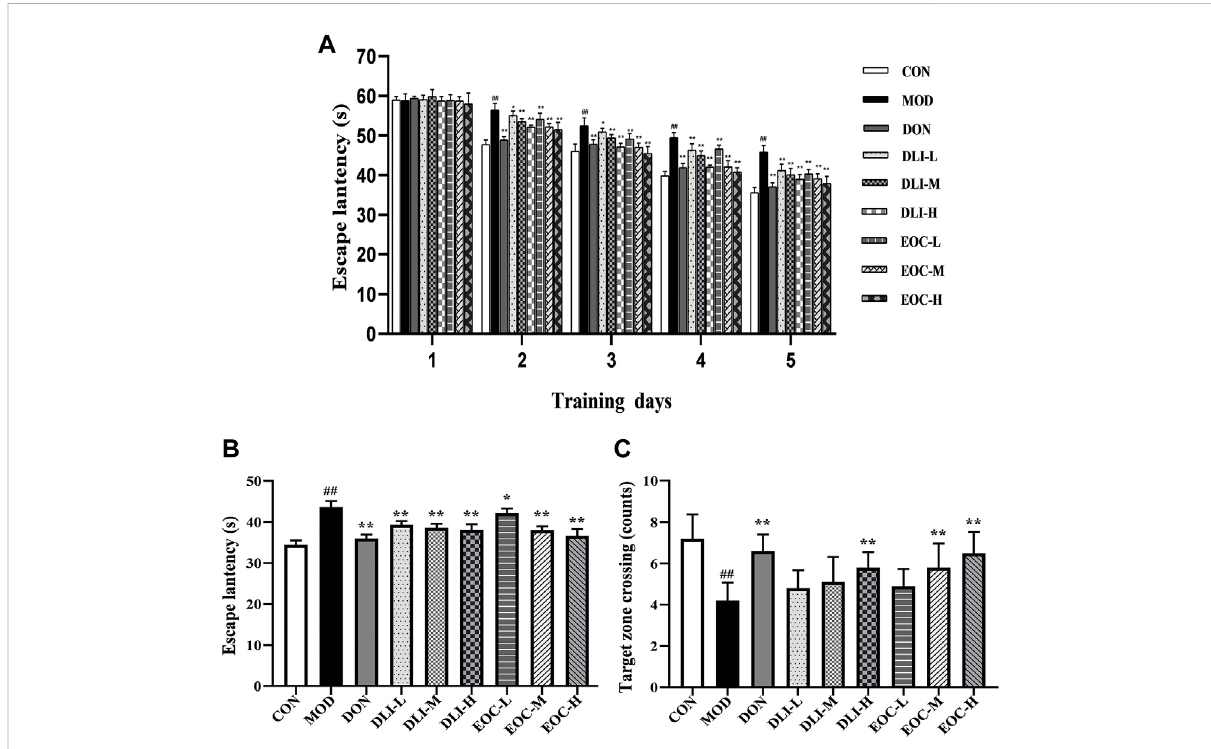
FIGURE 2 Effect of EOC and DLI on the Morris water maze test in mice ( n = 10). (A) The escape latency in the positioning navigation experiment. (B) The escape latency of fi rst entry into the target quadrant in the space exploration experiment. (C) The number of entries into the target quadrant in the space exploration experiment. # p < 0.05; ## p < 0.01 vs. the CON group; * p < 0.05, ** p < 0.01 vs. the MOD group.